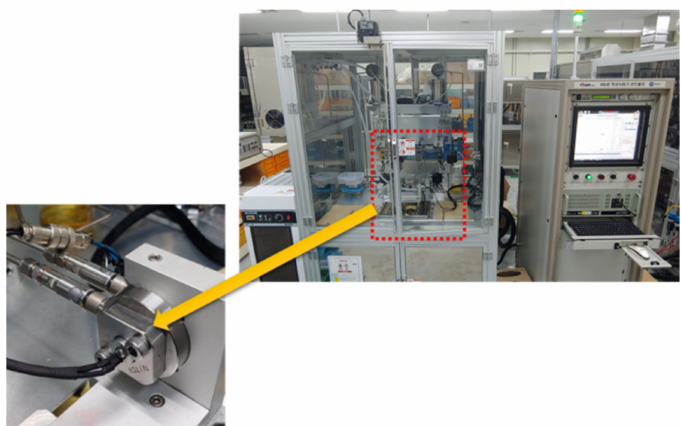
Figure 20. Function tester of TCV.